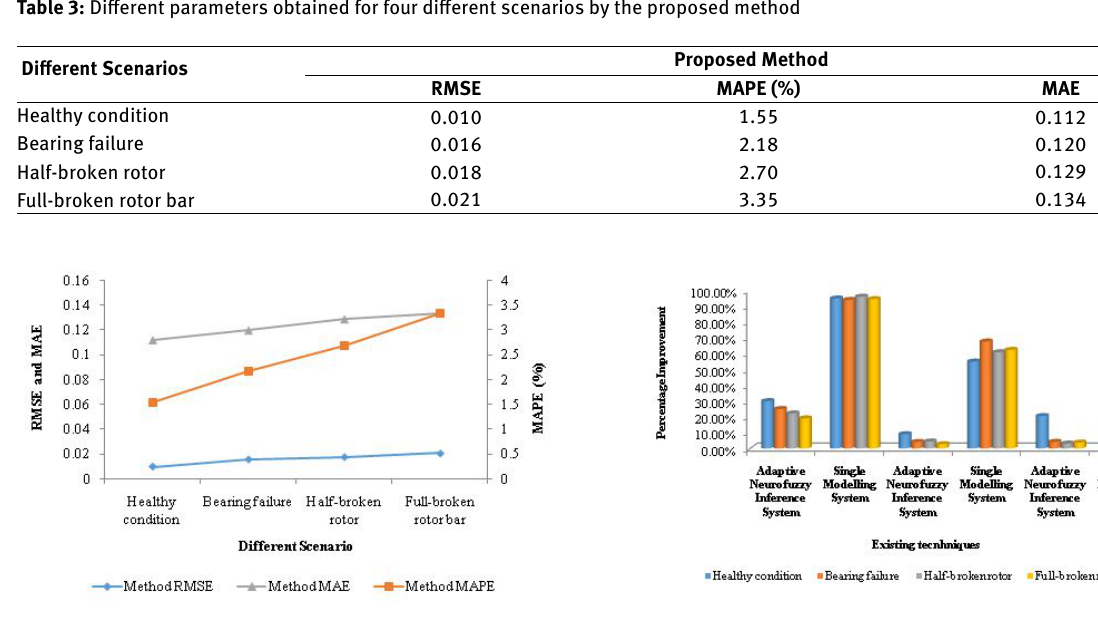
Figure 12: Percentage improvement of the proposed technique over existing